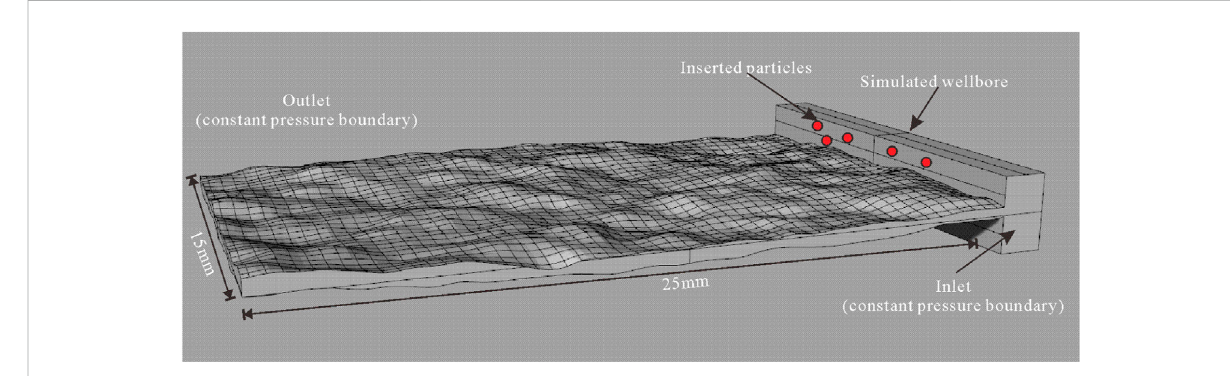
FIGURE 4 Schematic illustration and CFD mesh of the